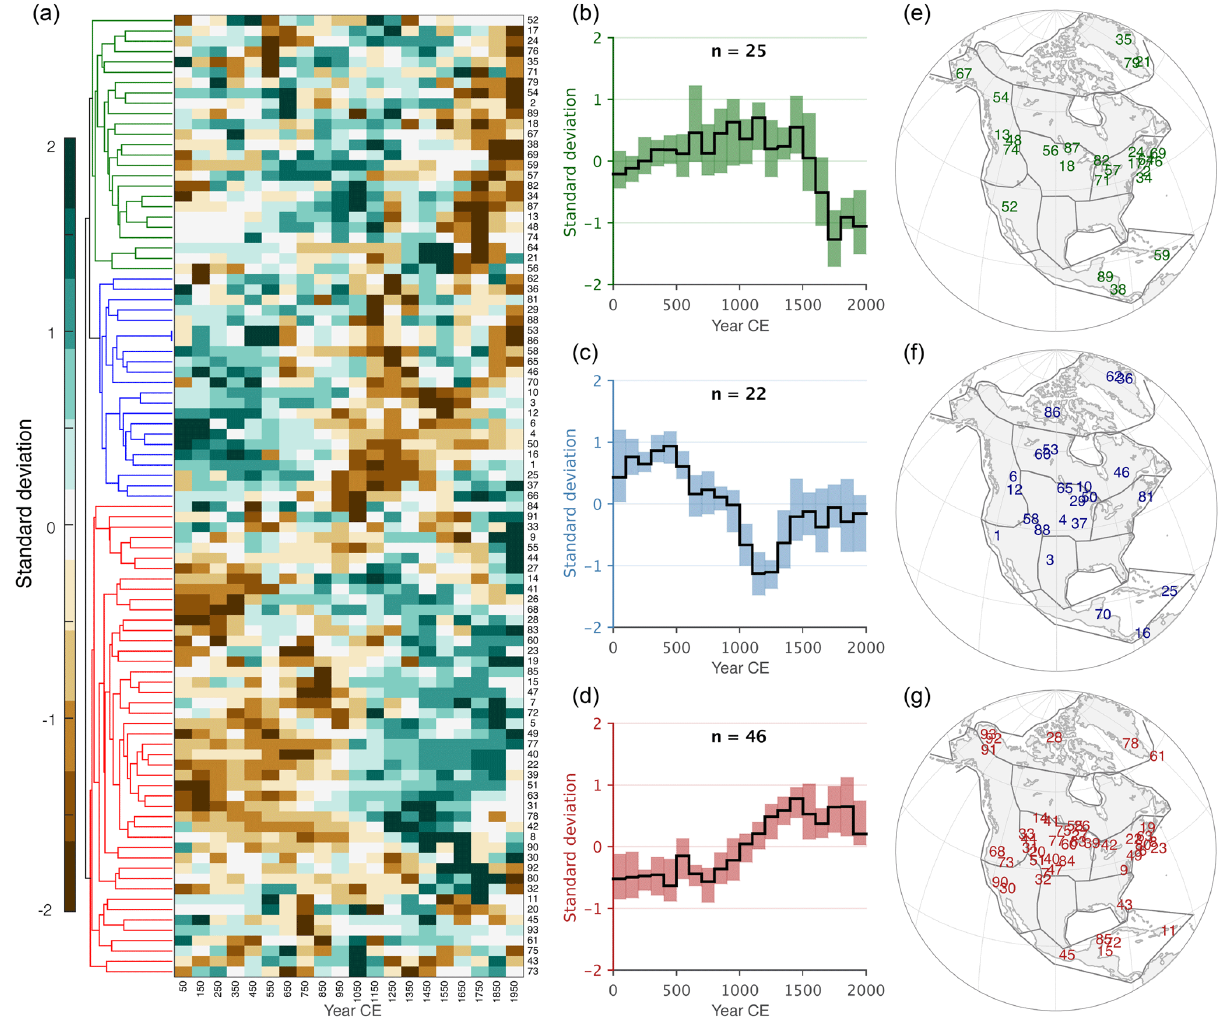
Figure 2. (a) Heat map, cluster analysis, and dendrogram of the standardized hydroclimate records used in this study. The clustering shows the dominant groups of temporal patterns represented by the hydroclimate records. (b–d) Average composites of the respective colored clusters in panel (a) . The shading shows the 95% bootstrap confidence intervals with 500 iterations. (e–f) The spatial distribution of records in each cluster; numbers correspond with those in panel (a)